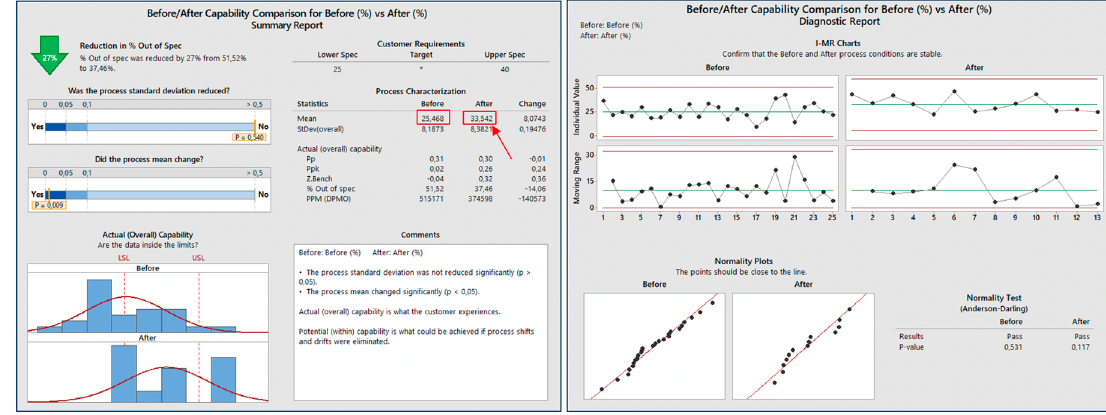
Figure 2. Overall Asset Effectiveness improvement.